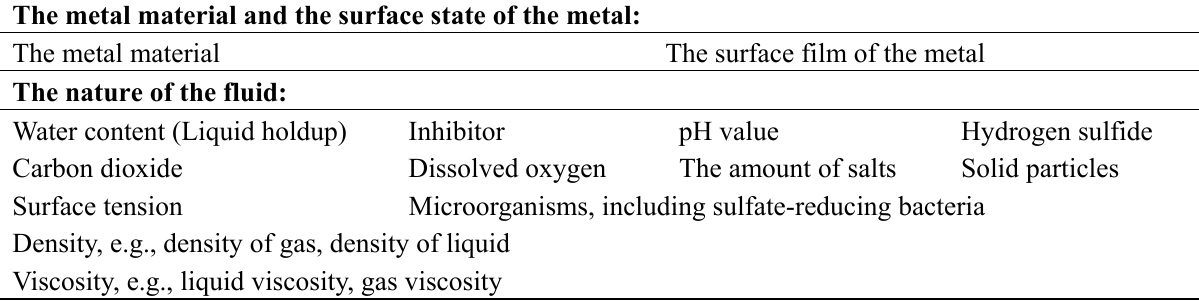
Table 2. The internal corrosion influencing factors that should be identified. The metal material and the surface state of the metal: The metal